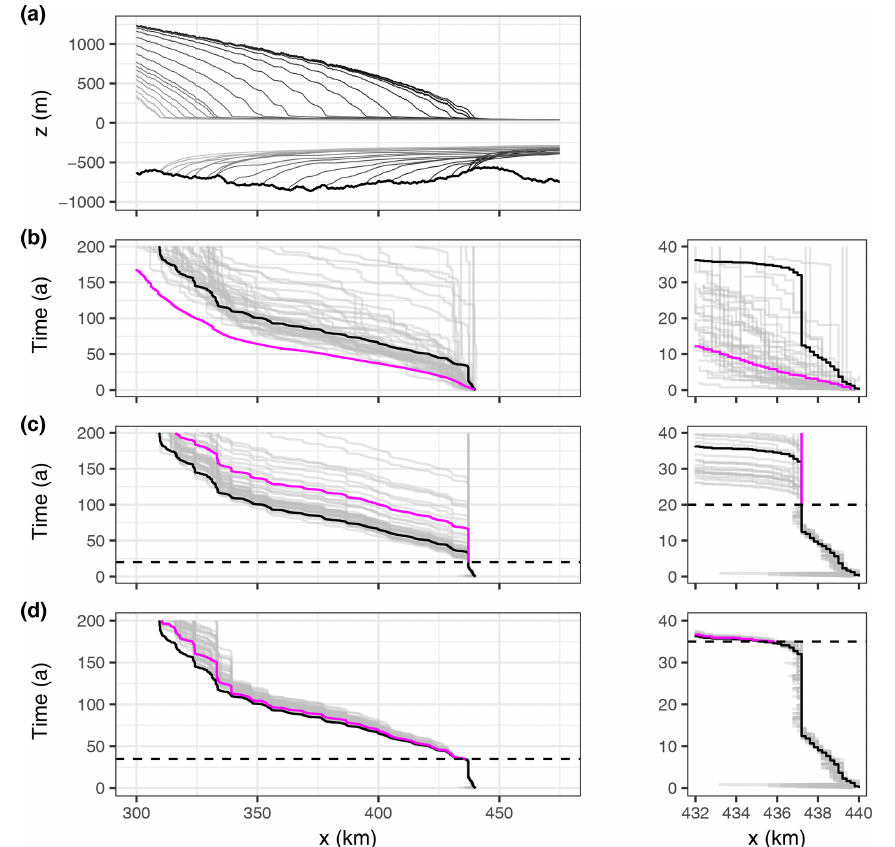
Figure 2. (a) Reference ice sheet topography every 10 years from t = 0 to t = 200 a (black to grey). (b) – (d) GL position as a function of the simulation time for the reference (black line), for the ensemble (grey lines), and for the deterministic forecast (magenta line) (b) without assimilation, (c) with assimilation up to t = 20 a and (d) with assimilation up to t = 35 a. The right column shows a zoom on the first 40 years. In (c) – (d) , the horizontal dashed line shows the end of the assimilation